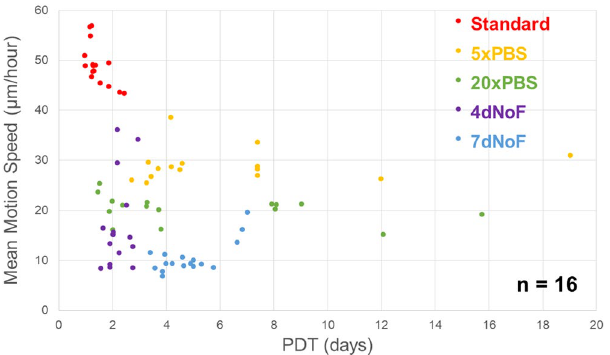
Figure 3. Distribution of the MMS of p1 oral keratinocytes with their proliferative capacity under metabolic challenge protocols compared with that under the standard protocol. Scatterplot showing the MMS and PDT of p1 oral keratinocytes cultured under two types of metabolic challenge protocols (low nutrition (5×PBS, 20×PBS) and no feeding (4dNoF, 7dNoF)), as well as the standard cell culture protocol. Distinctive pattern of sample distribution is present between cells cultured under standard protocol and metabolic challenges when grown in a 2D monolayer culture. (n = 16 individuals).